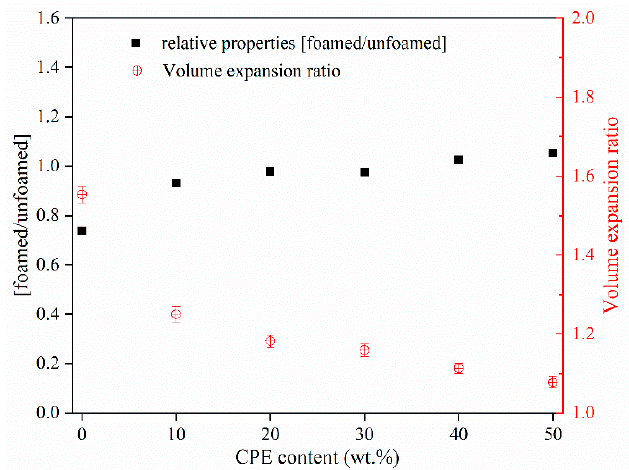
Figure 10. Relative properties for the foamed samples of SAN and SAN/CPE blends.